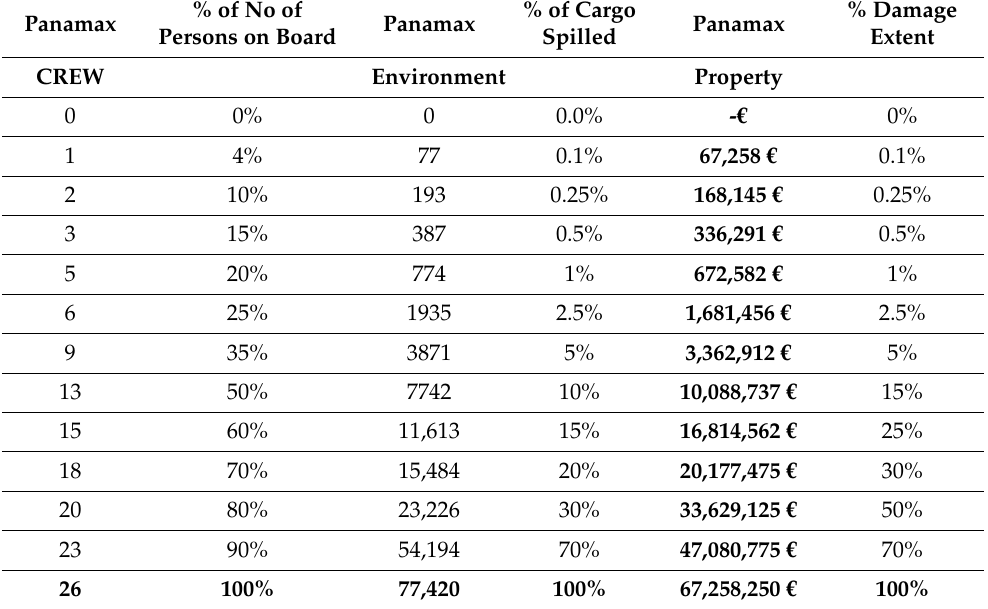
Table 4. Ship band characteristics for Panamax